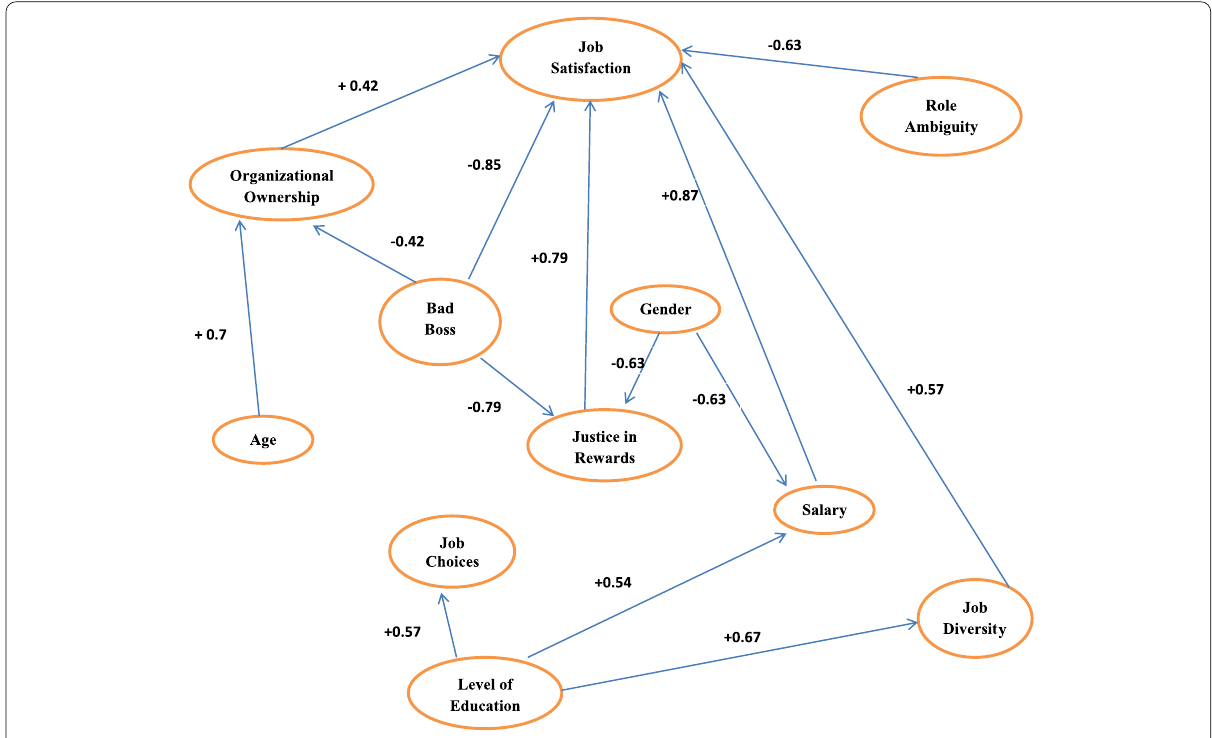
Fig. 4 Cognitive map of the factors affecting the ICT staff